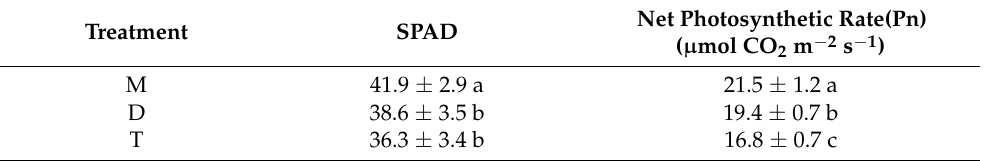
Table 7. Effect of seeding pattern on leaf chlorophyll content and net photosynthesis rate of peanut.